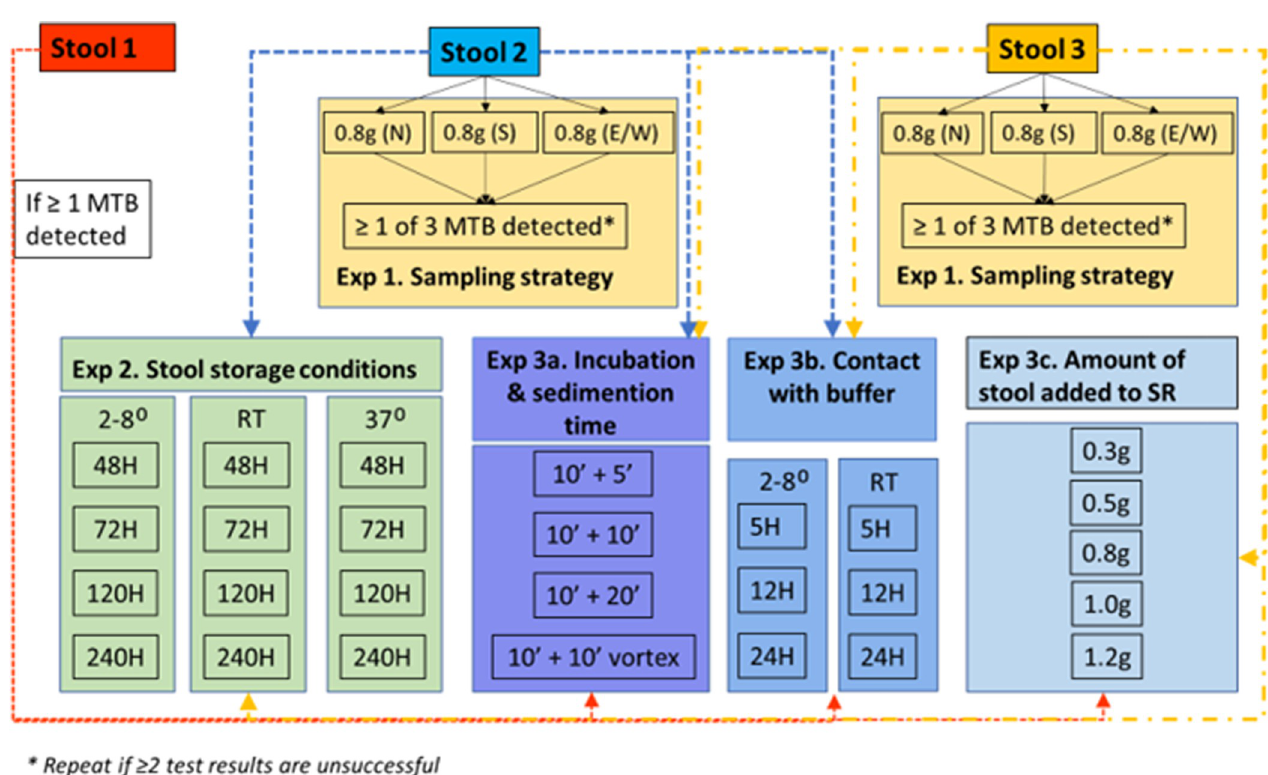
Fig 2. Overview of experiments. Arrows indicate what experiments are done with the different stool specimens. Note that for adult participants, in principle all experiments will be done on all three stool samples, provided that enough stool is collected per bowel movement. Abbreviations used: MTB, M. tuberculosis; N, North; S, South; E/W, East or West; Exp, experiment; RT, room temperature; H, hours; SR, sample reagent; g, gram.